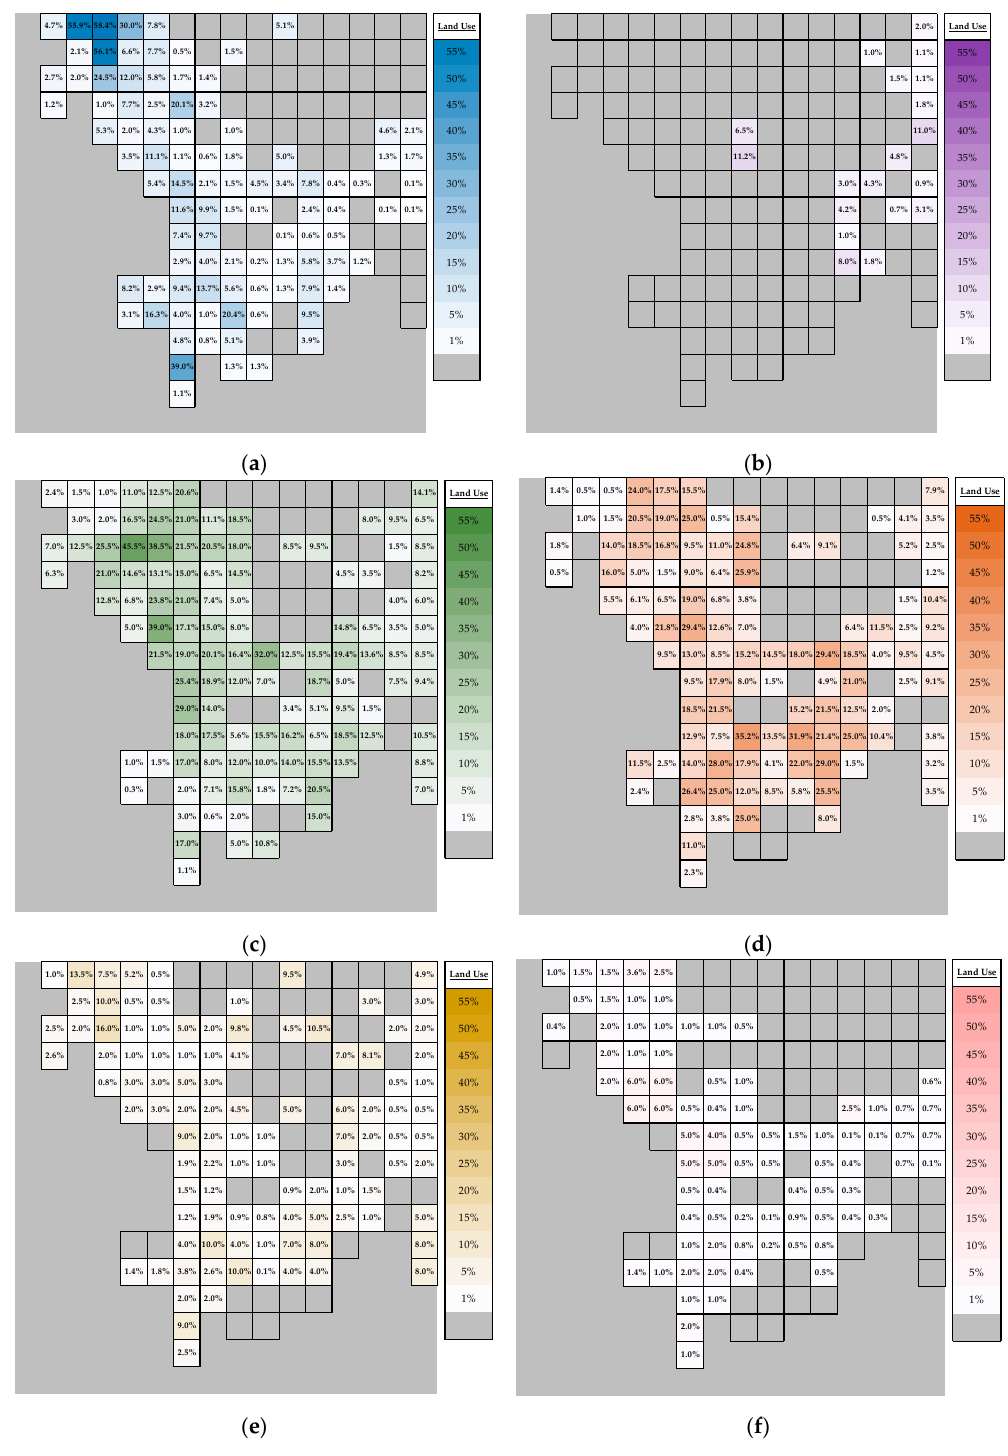
Figure A2. Future land use as percentage (%) of the small area’s size ( a ) sum of business and commercial land use; ( b ) industrial land use; ( c ) low residential land use; ( d ) high residential land use; ( e ) sum of governmental and utilities land use; ( f ) transportation land use.